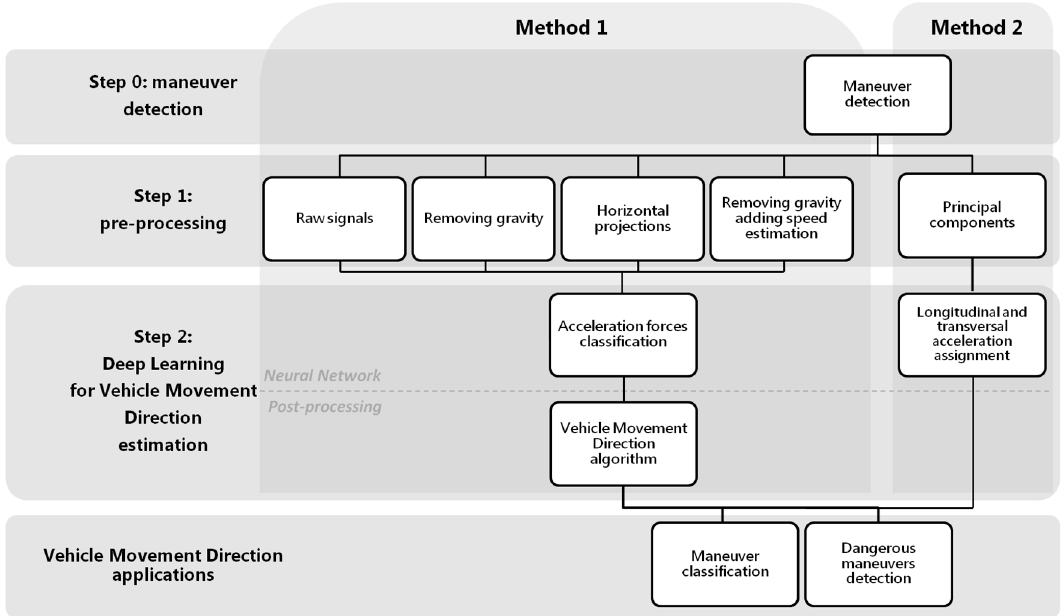
Figure 1. Scheme methods for obtaining vehicle movement direction (VMD).